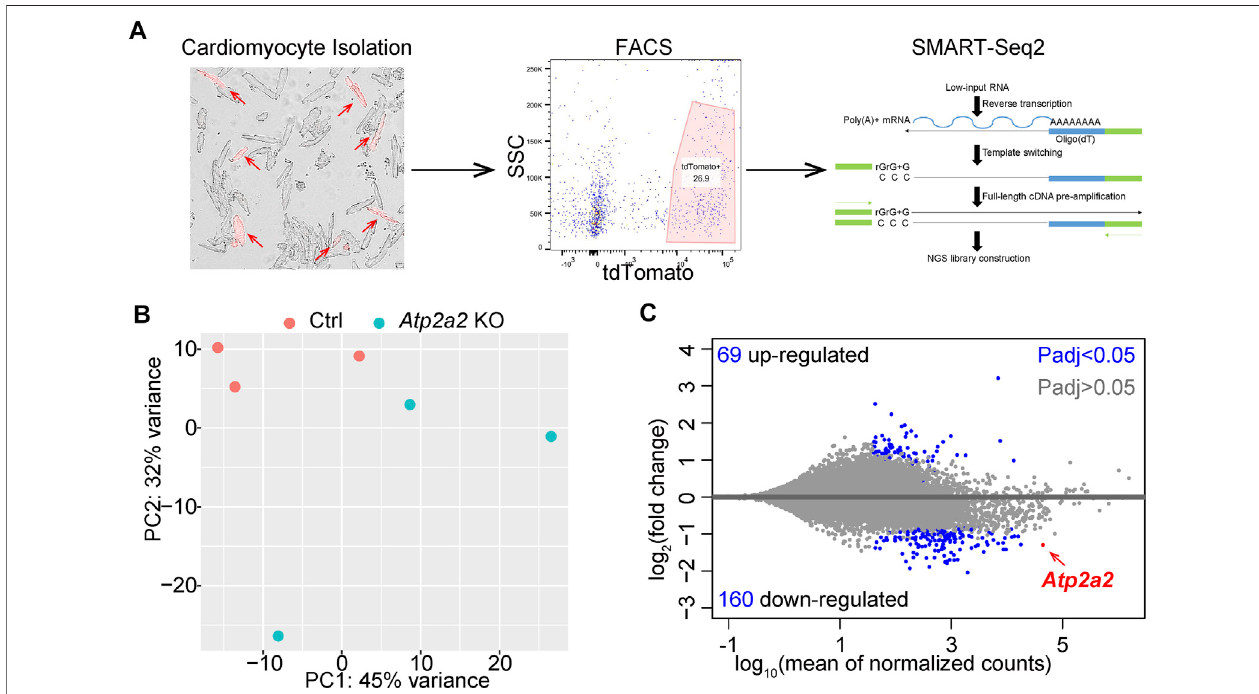
FIGURE6| RNA-SeqanalysisofFACS-enrichedcardiomyocytes. (A) ,AdiagramofFACS-RNA-Seqwork fl ow.Representativeimagesofisolatedcardiomyocytes, fl owcytometrygating,andtheprincipleofSMART-Seq2areshown.RedarrowspointtotdTomato+cardiomyocytes. (B) ,PCAplotofindividualRNA-seqdata. (C) ,MA plot of differential expression analysis. B and C were generated with the DESeq2